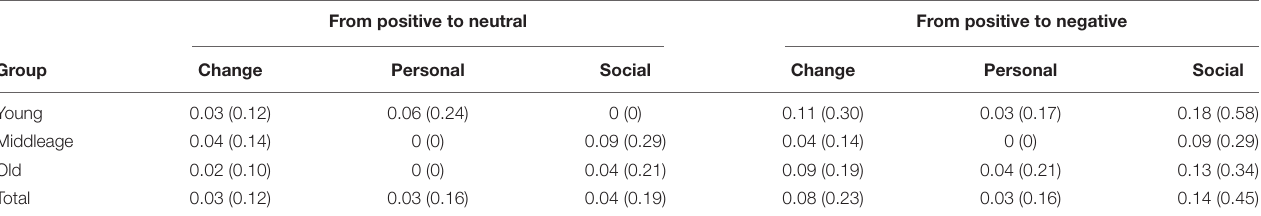
TABLE 4 | Mean proportion (SD) of changes in valence from initially positive to neutral or negative statements, for personal and social statements in young, middle-aged, and older adults. From positive to